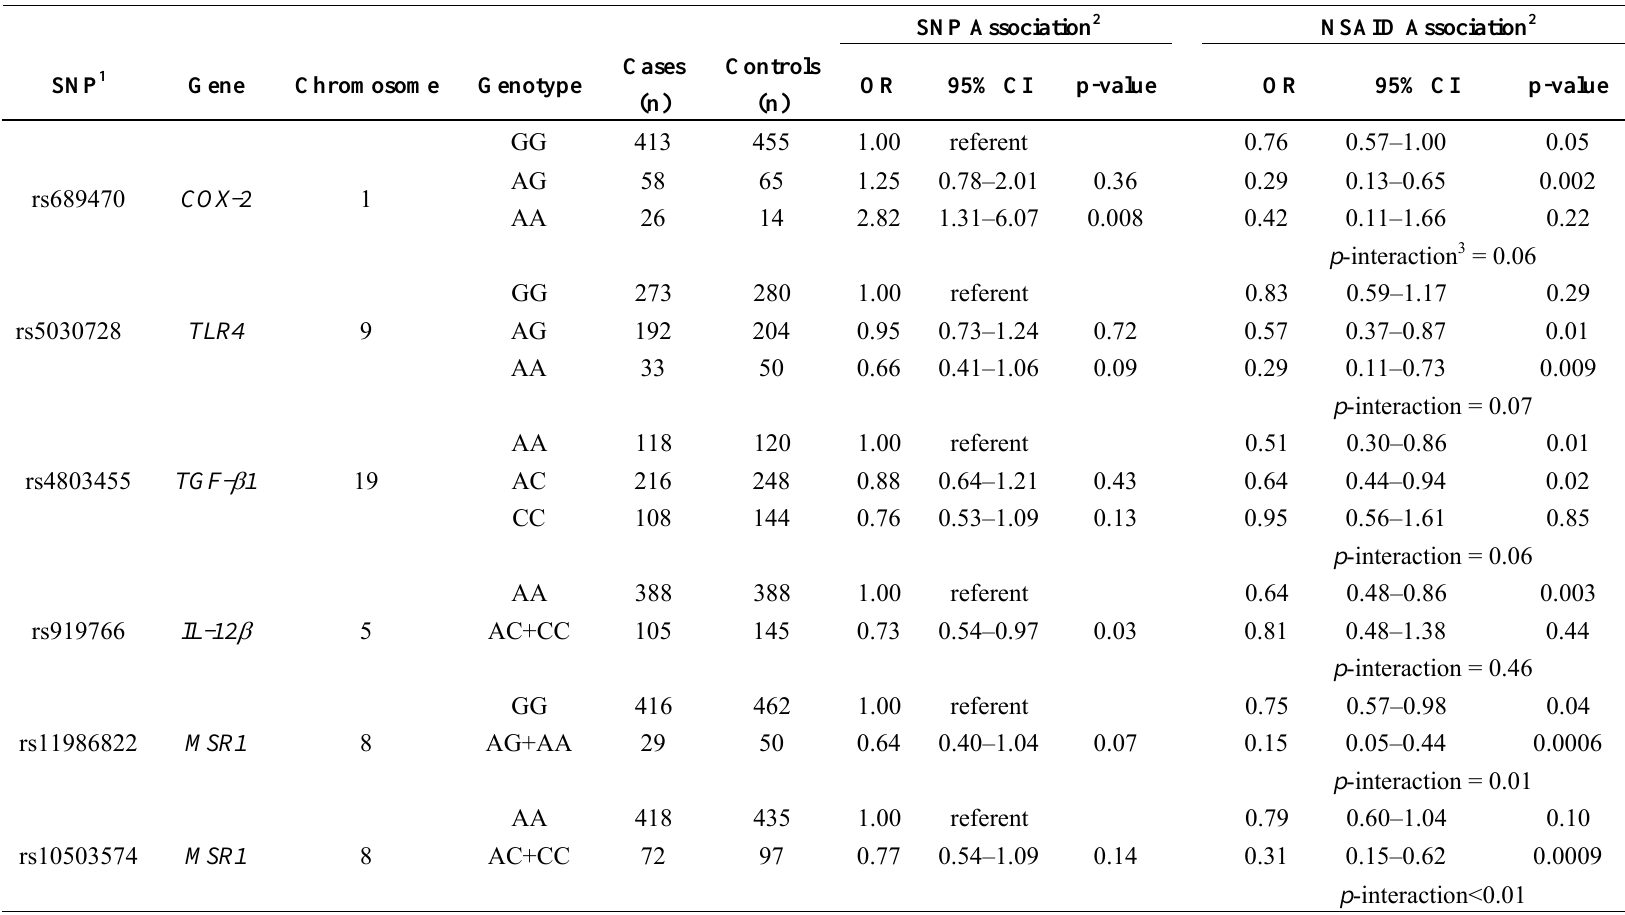
Table 5. Association Between Candidate SNPs and Aggressive Prostate Cancer, and Modification of NSAID Protective Effect by these